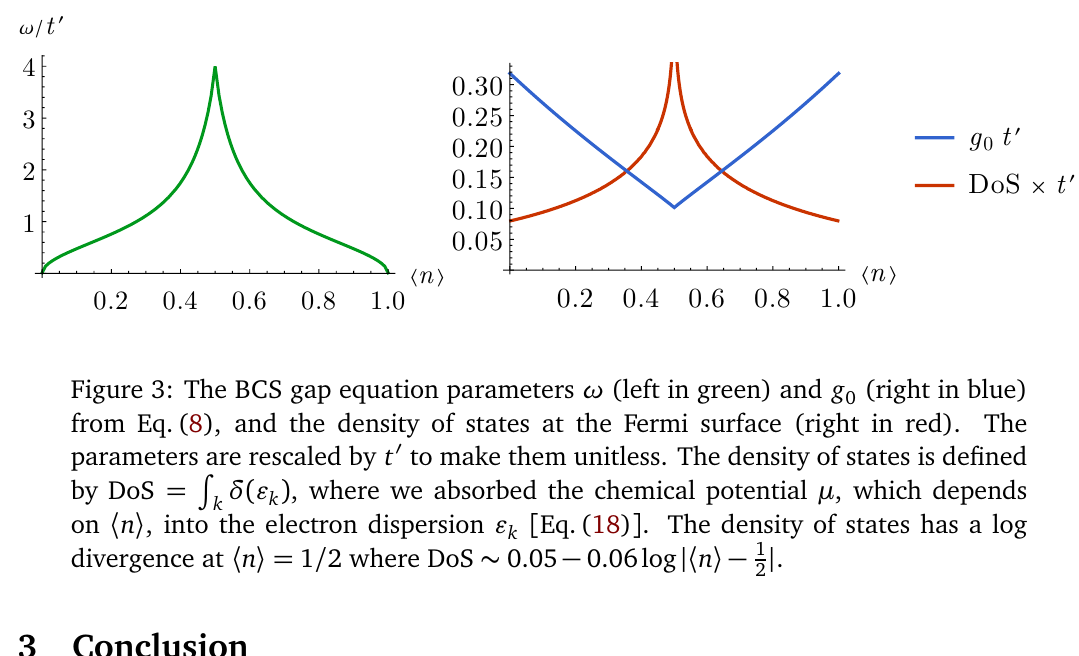
Figure 2: The nodal lines of the order parameter [ black lines where ∆ and the fermi surface for various electron fillings (colored lines). The symmetry of the order parameter depends on the electron filling. When t (cid:48) > 0, the symmetry is d-wave when 〈 n 〉 < 1 / 2 and s-wave when 〈 n 〉 > 1 / 2. The nodal lines never touch the fermi surface as long as 〈 n 〉 (cid:54) = 1 / 2. The t (cid:48) < 0 case follows from noting that the physics is symmetric under t (cid:48) → − t (cid:48) and 〈 n 〉 → 1 − 〈 n 〉 .